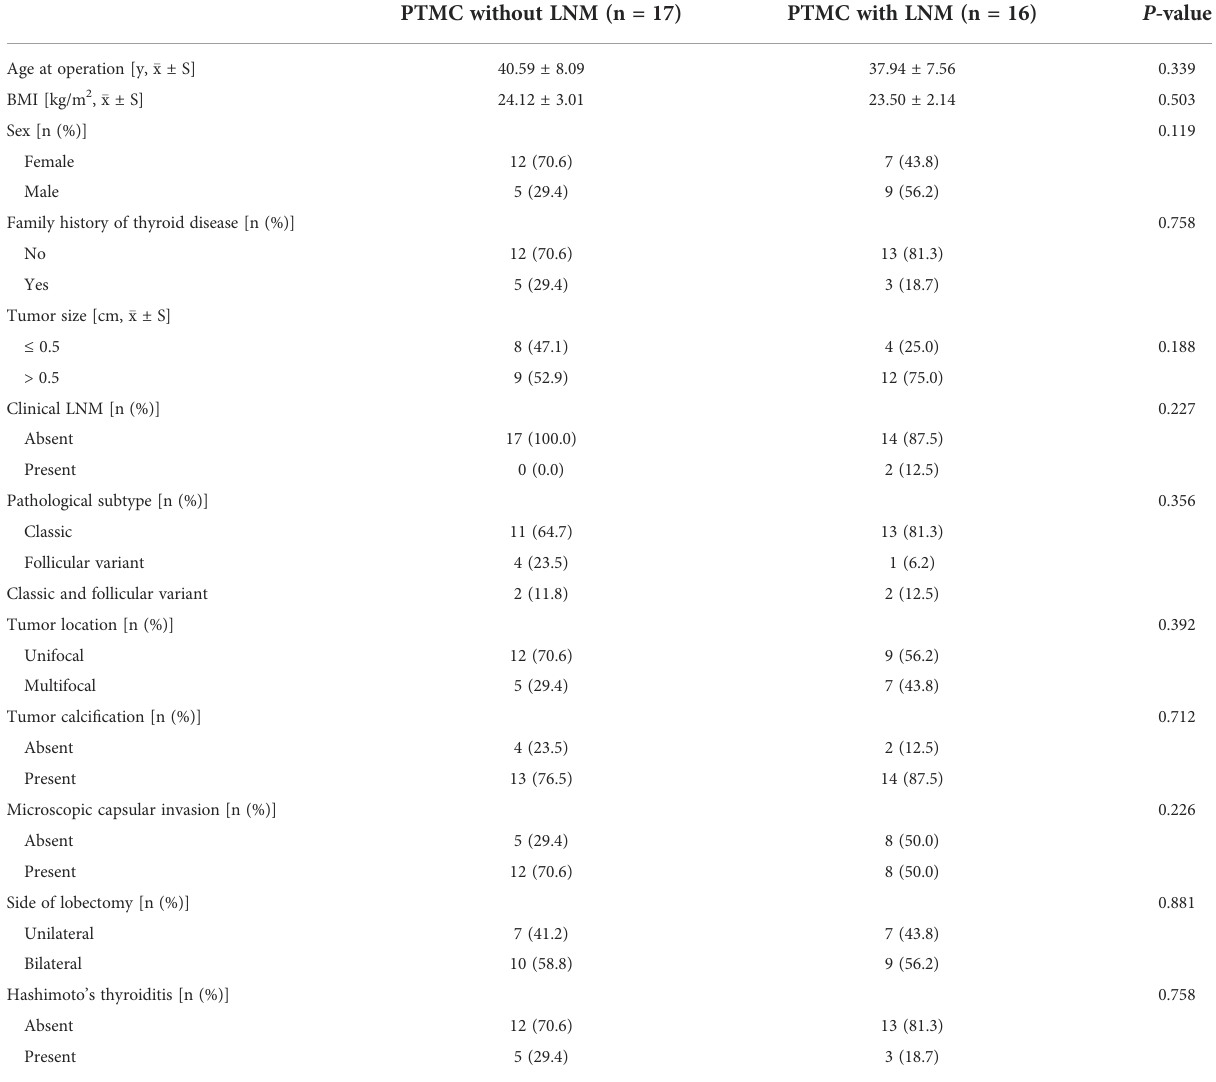
TABLE 1 Clinical and pathological characteristics of the subjects used for proteomics